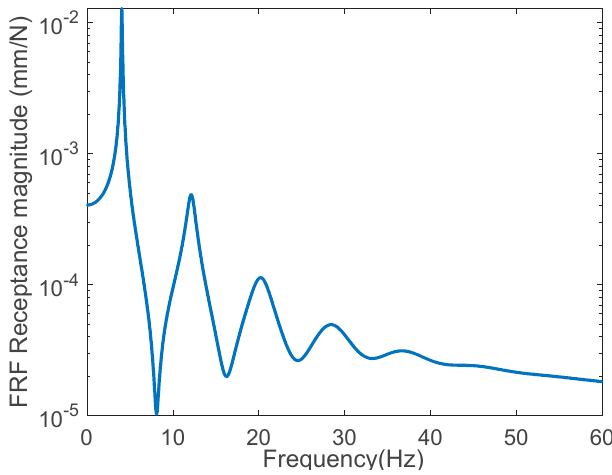
Figure 6. FRF receptance curve of a cantilevered beam. Table 2. Summary of the impact hammer test on a cantilevered beam.